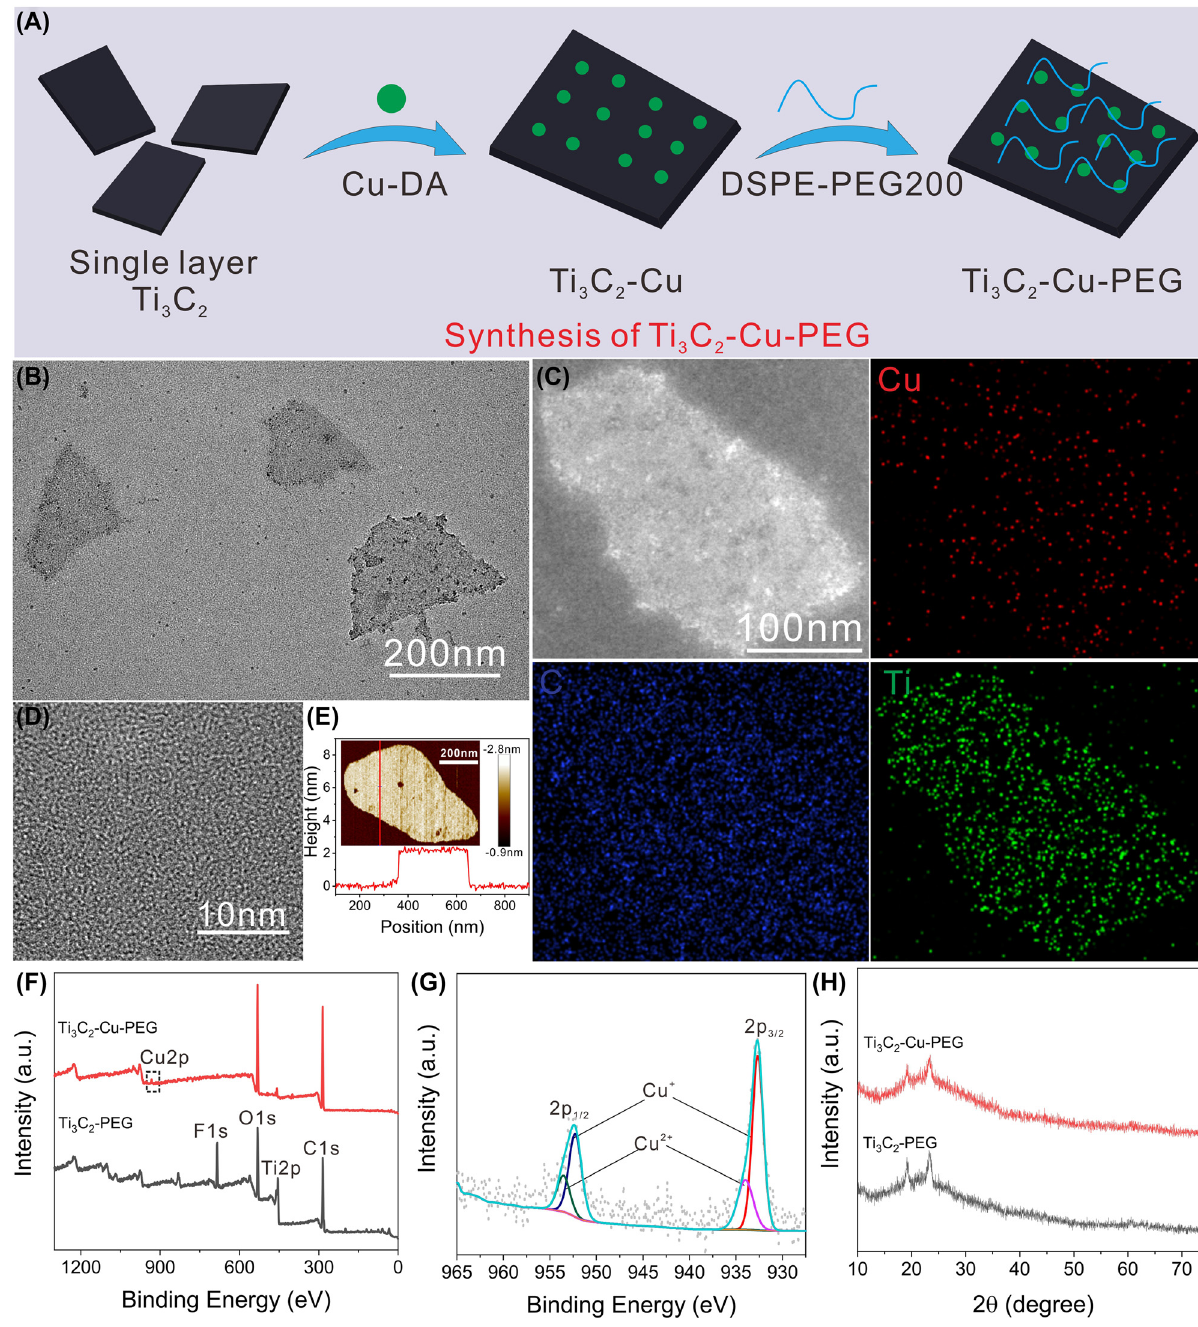
C -Cu-PEG. (A) Schematic illustration of the synthesis of Ti 3 2 C -Cu-PEG. (C) Elemental mappings images, and HAADF-STEM images (D) of Ti3C2-Cu-PEG. (E) was measured 3 2 C -PEG and Ti C -Cu-PEG. 3 2 3 2